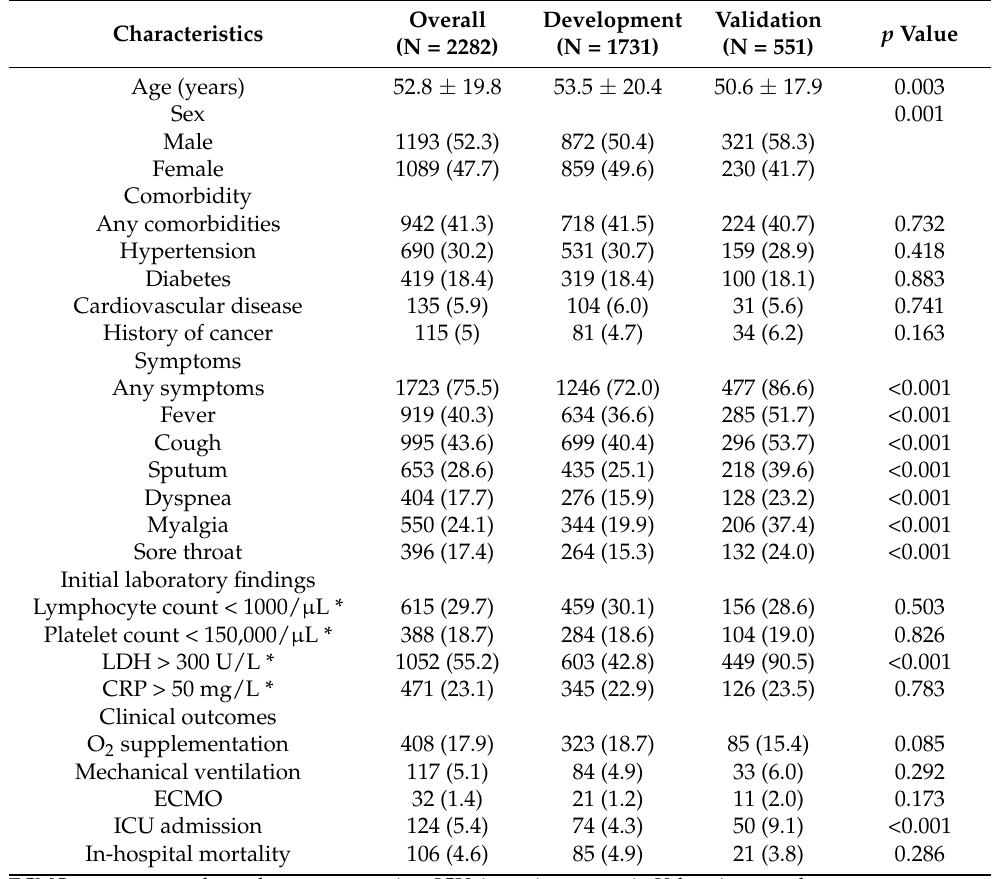
Table 1. Baseline characteristics of patients from all